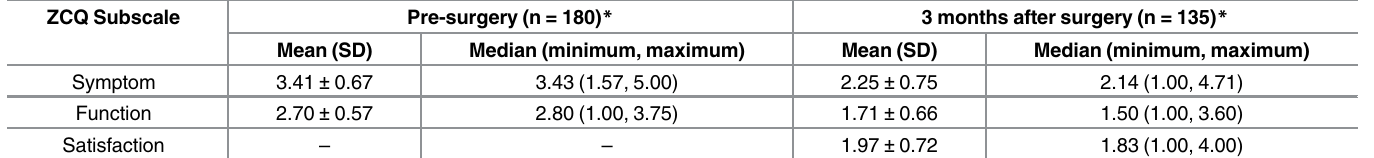
Table 2. Distribution of the Zurich Claudication Questionnaire (ZCQ) subscales. ZCQ